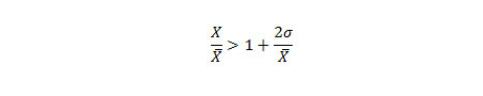
Figure 2. Historical limits method (HLM) equation. Sigma = standard deviation, X = number of reported cases in the current period, X-bar = mean.